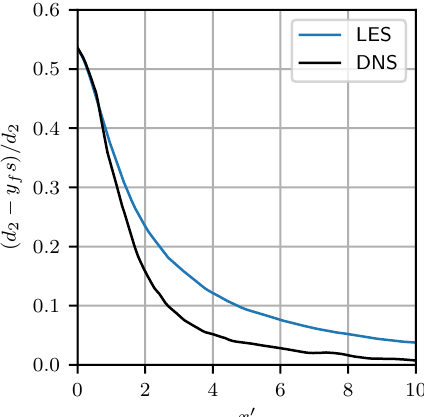
Figure 4. Convergence of the interface height towards d 2 in the benchmark simulation.